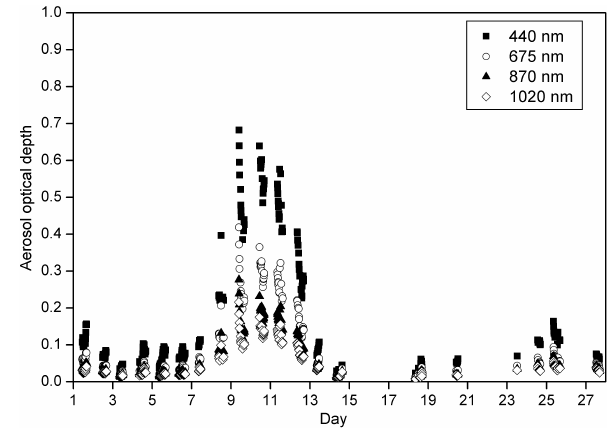
Fig. 1. Evolution of the spectral aerosol optical depth obtained from the AERONET inversions during the period of study (Febru- ary